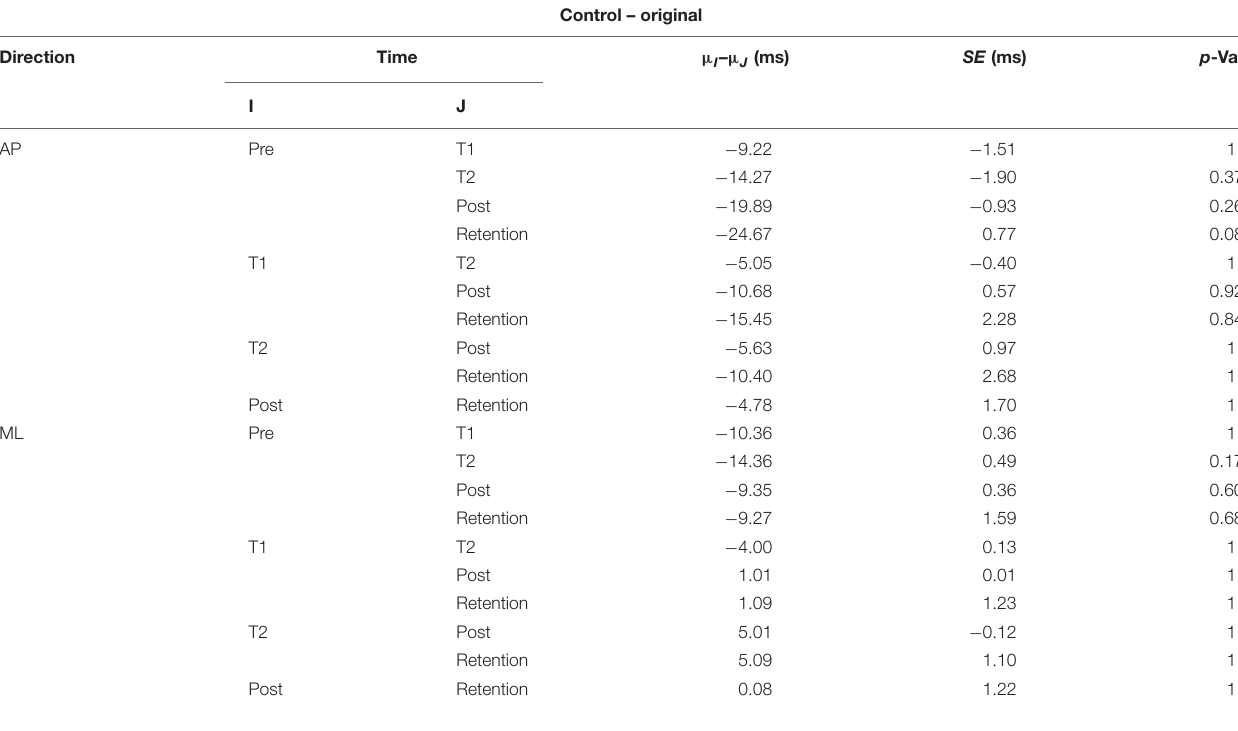
TABLE 4 | Results of the post hoc tests for the EnHL values of the original CoP signals of the control group ( µ : mean; SE: standard